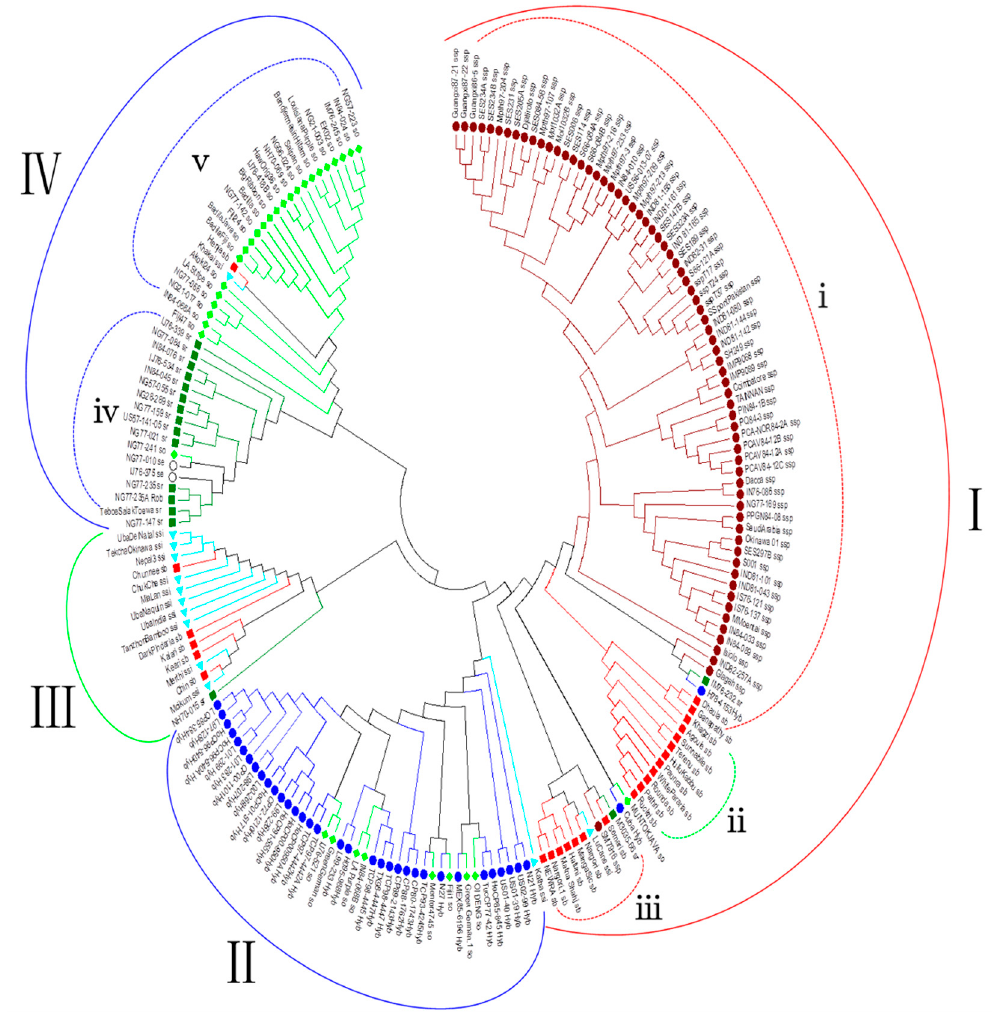
Figure 2. Phylogenetic tree for 196 accessions created by MEGA 7 based on SSR data. Each accession was marked by species as below: S. spontaneum (tan round), S. robustum (green square), S. officinarum (green diamond), S. sinense (blue triangle), S. barberi (red square), Saccharum spp. hybrids (blue round), and S. edule (white round). Four main clades are marked as I , II , III , and IV by full curves; five sub-clades are marked as i , ii , iii , iv , and v by dotted curves, with corresponding colors (red, green, and blue) of K3 gene pools (Q1, Q2, and